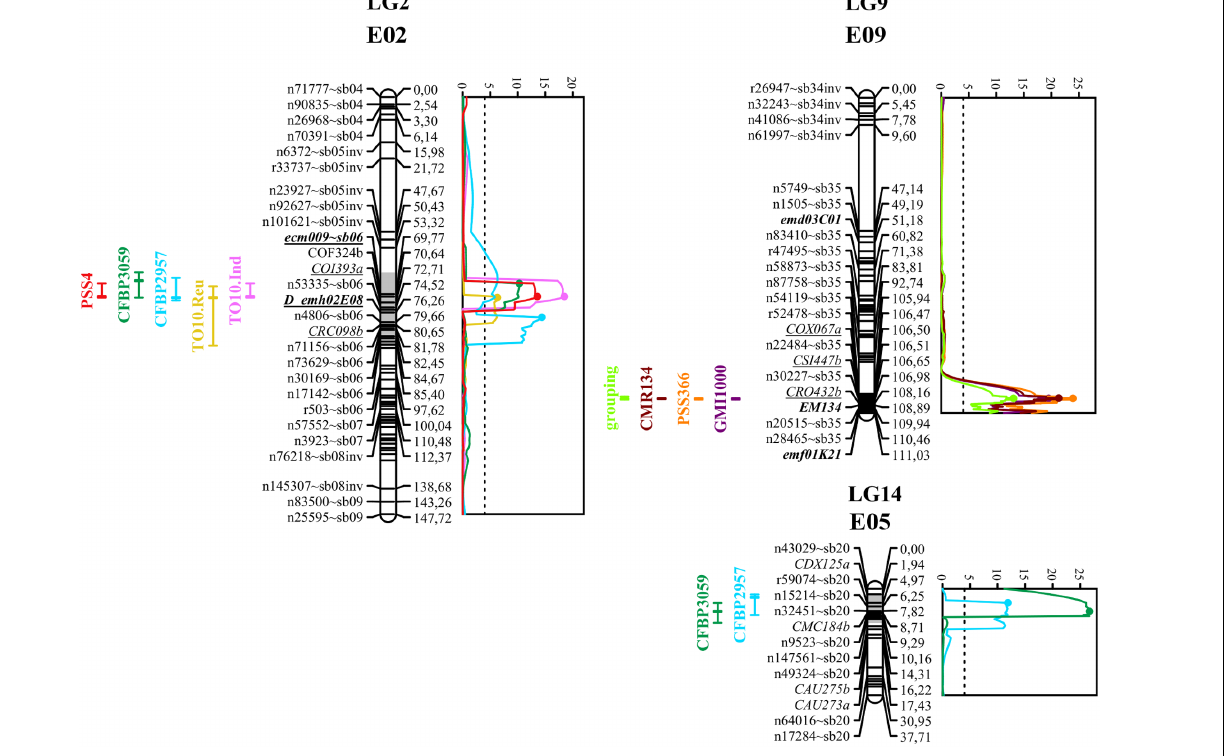
Frontiers in Plant Science |